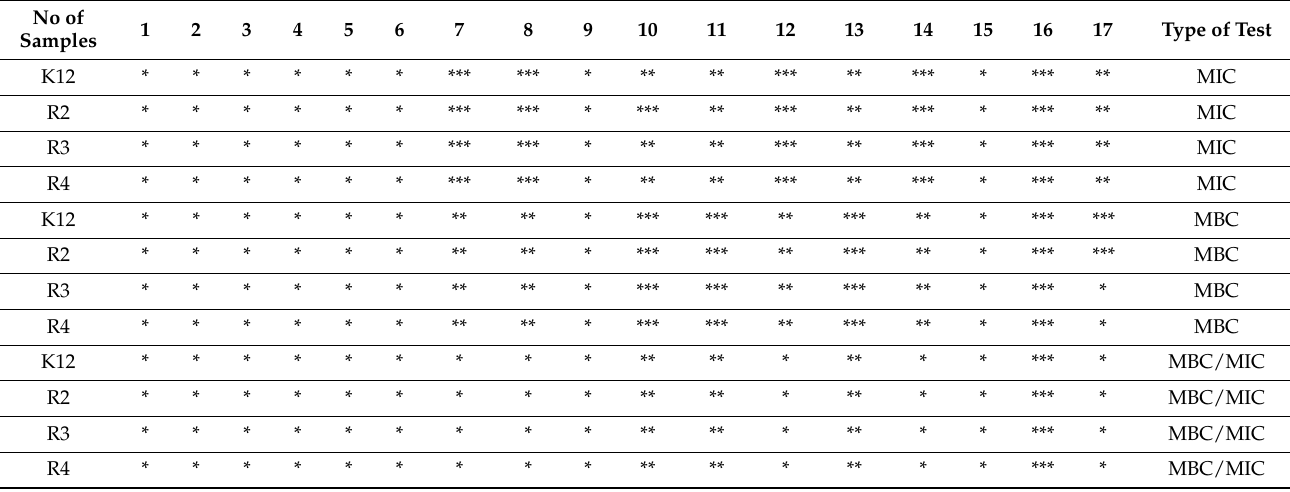
Table 2. Statistical analysis of all analyzed 17 compounds at p < 0.05 *, p <0.01 **, and p <0.001 *** in MIC, MBC, and MBC/MIC tests. Lactones 1–17 were used sequentially.